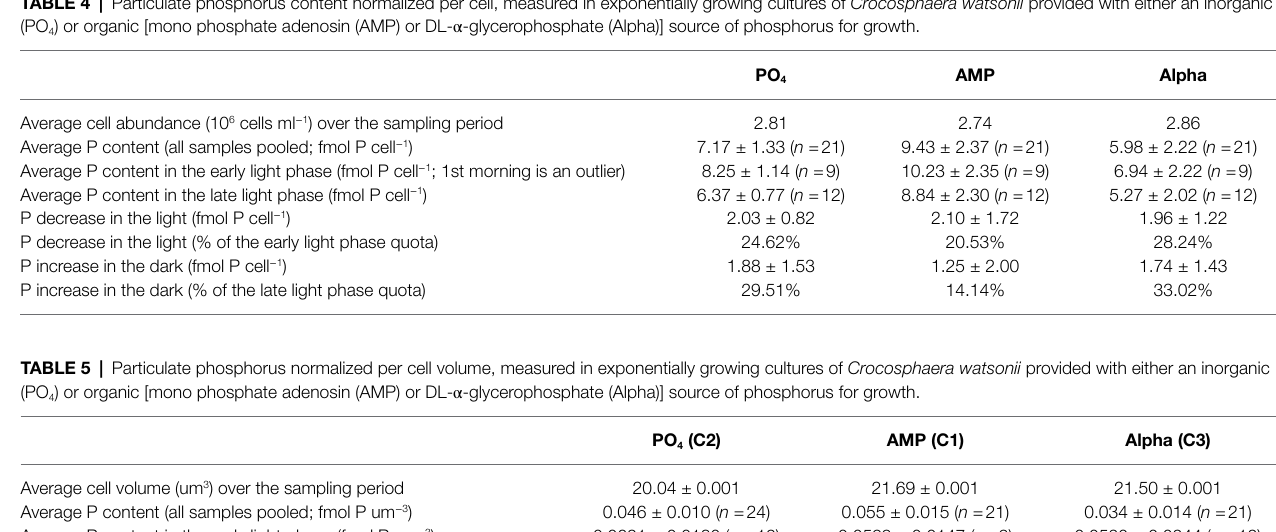
Average cell volume (um 3 ) over the sampling